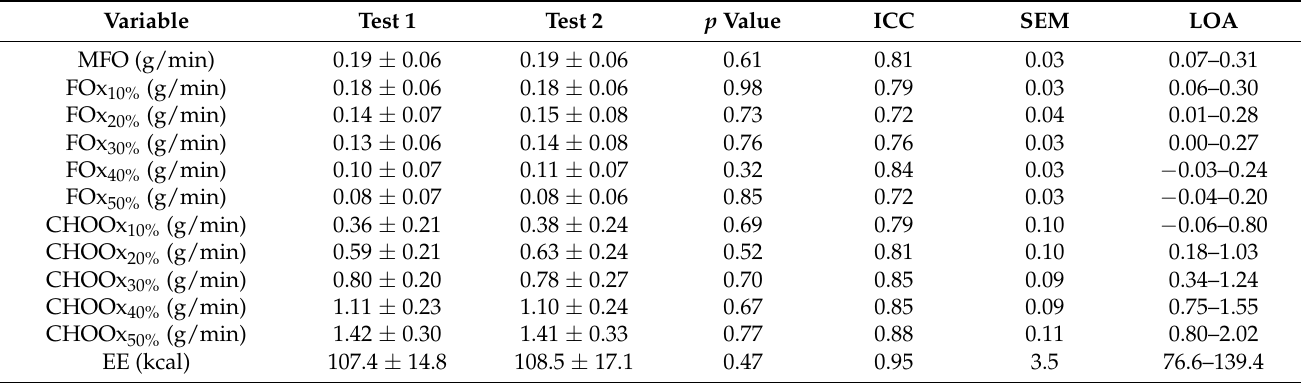
Table 2. Average MFO (maximal fat oxidation), fat and carbohydrate oxidation, intraclass correlation coefficient, standard error of the mean, and limits of agreement from repeated progressive exercise tests performed at baseline by inactive women at intensities ranging from 10%–50%PPO (mean ± SD). ICC: Intraclass correlation coefficient; SEM: standard error of the mean; LOA = limits of agreement; EE = energy